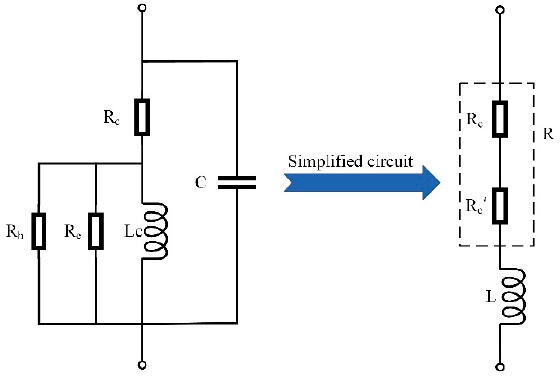
Figure 4. Displacement transducer single coil equivalent circuit.